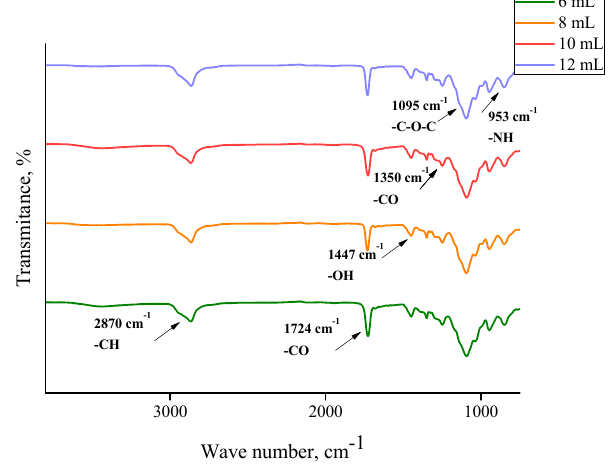
Figure 4. FTIR spectra of materials with different contents of crosslinking agent PEGDA 700.